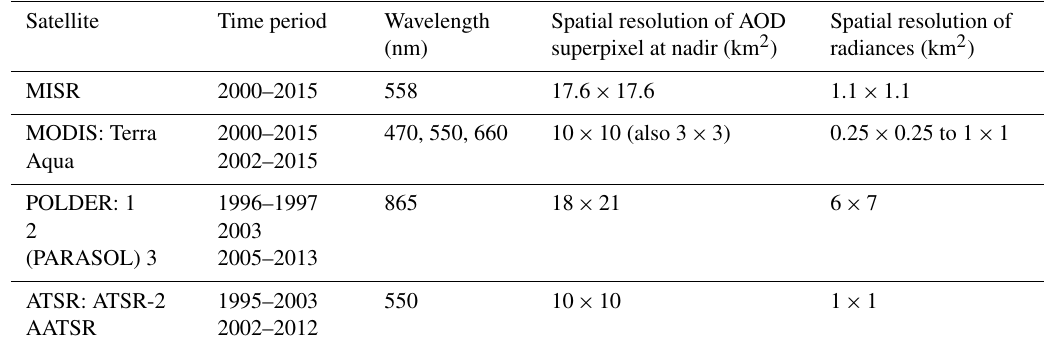
Table 1. Spatial resolution of AOD data products from selected satellite instruments. The third column contains the wavelength at which aerosol optical depth is reported in each satellite data product. MISR and both MODIS instruments are currently